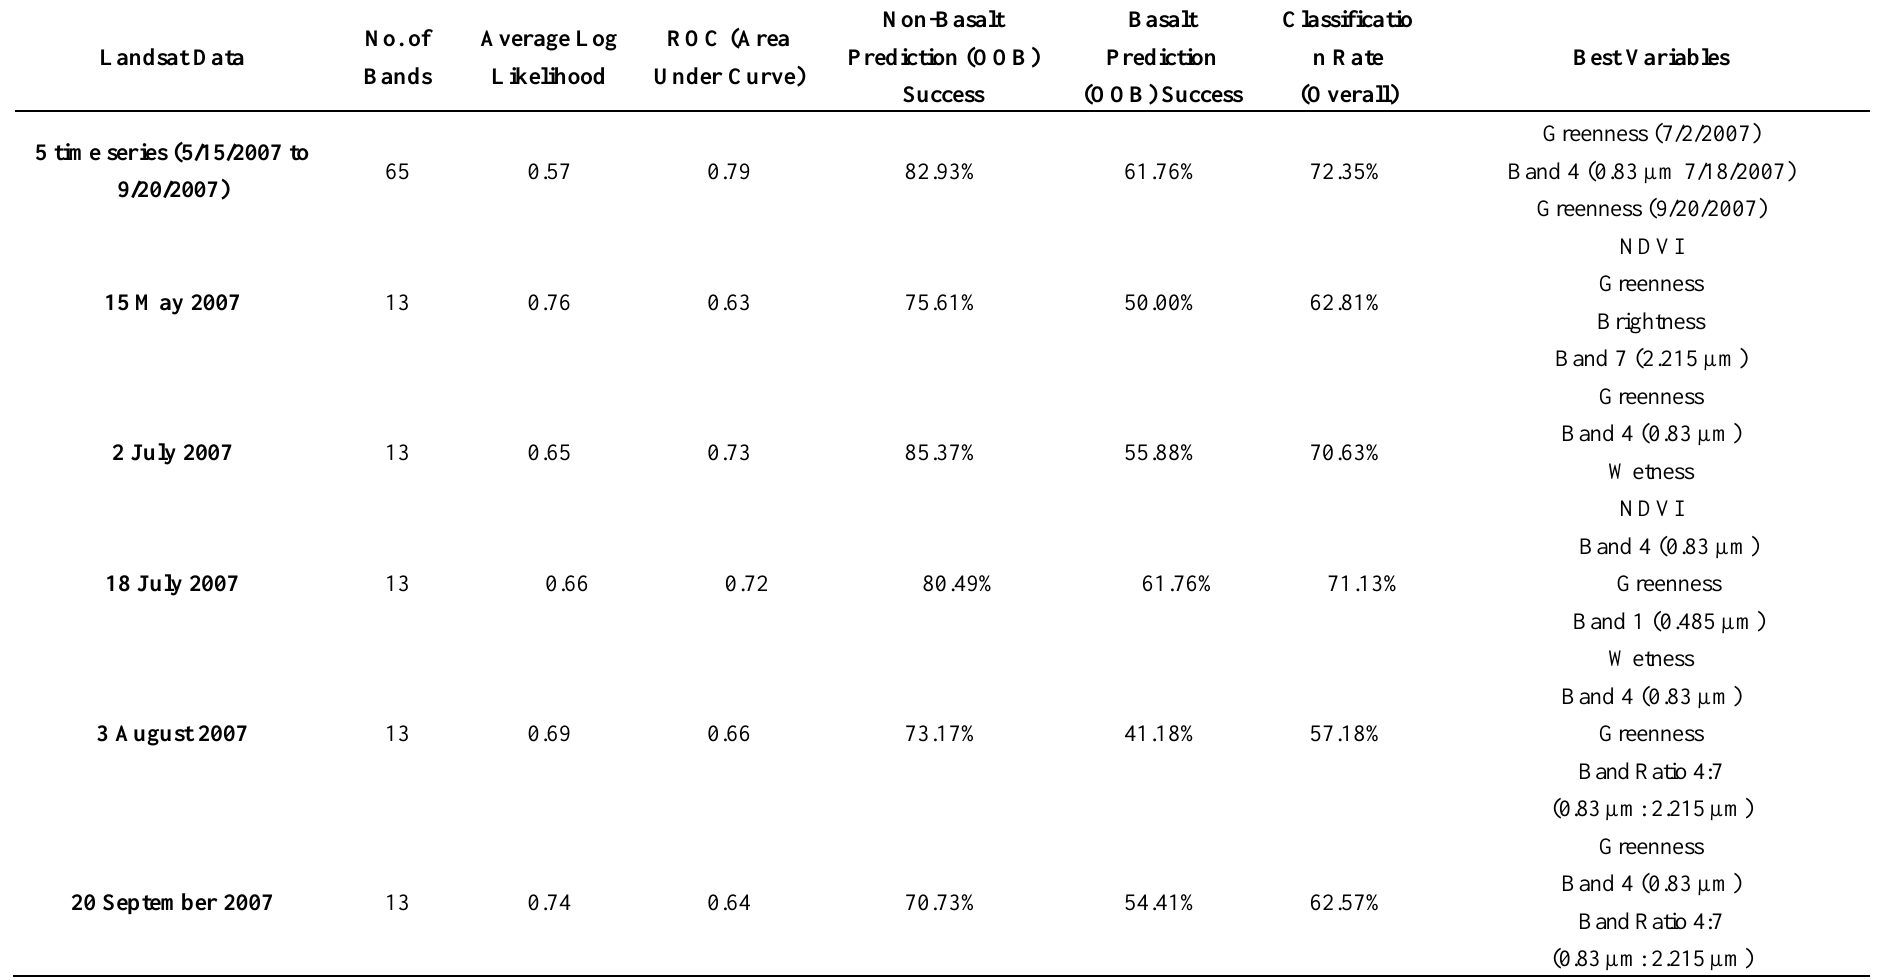
Table 2. A comparison of classification accuracy results obtained using Random Forest (RF) to detect basalt outcrops. ROC, receiver operator characteristic; OOB, out-of-bag; NDVI, Normalized Difference Vegetation